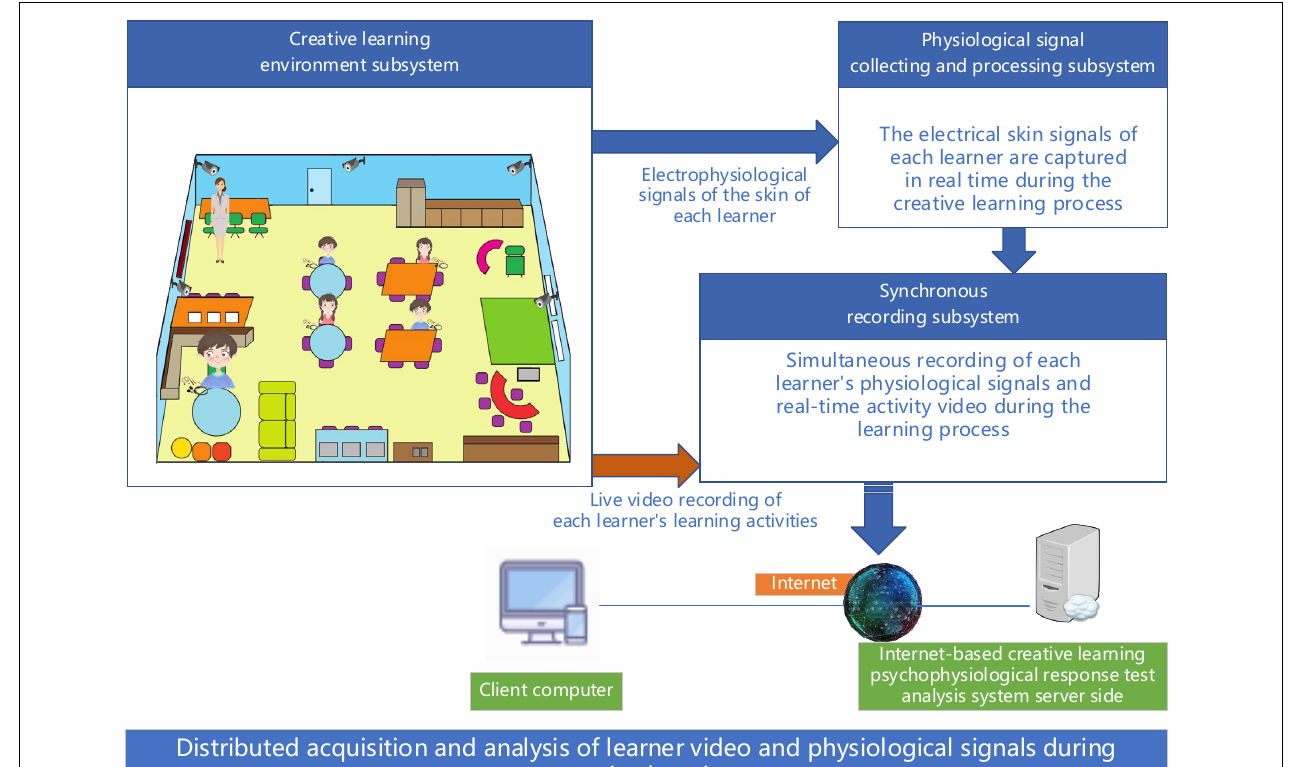
FIGURE 1 | Components of the system.